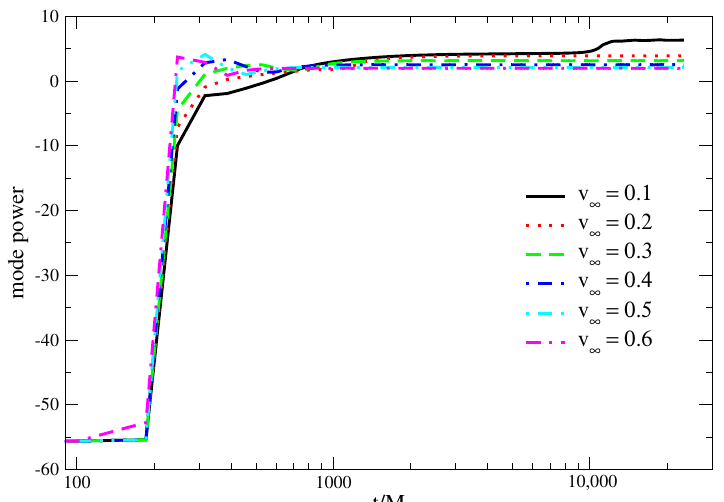
Figure 9. The evolution of m = 1 mode power for EGB black hole with α =